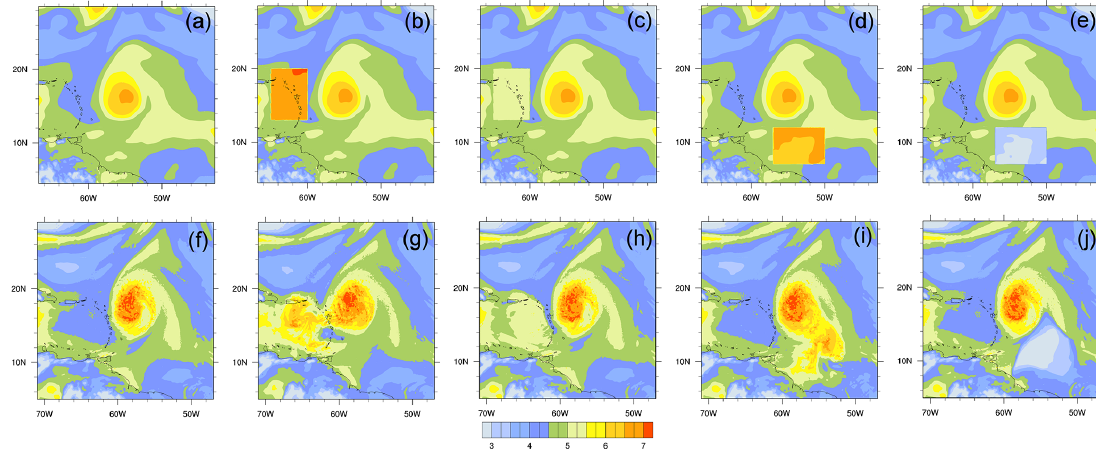
Figure 1. Column-integrated PWV (cm) at the initialization of the WRF simulations: (a) CTRL, (b) MF, (c) MFI, (d) MR and (e) DR; 12h forecast for (f) CTRL, (g) MF, (h) MFI, (i) MR and (j)